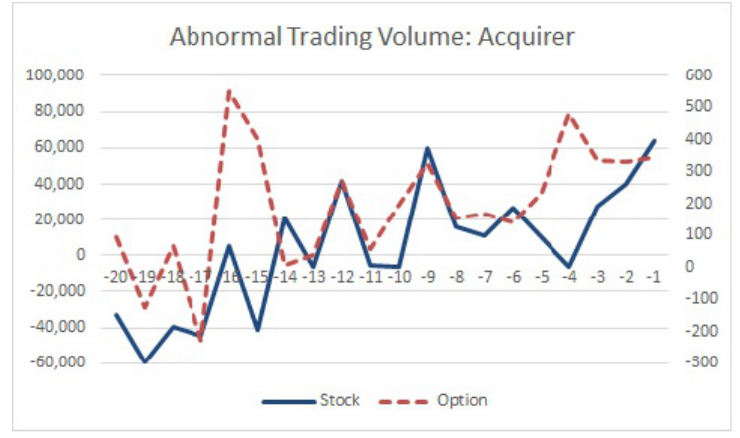
Figure 1. Stock and Option represent the average daily abnormal trading volume of acquirers’ stocks and options over the 20-day period prior to the announcement, respectively.